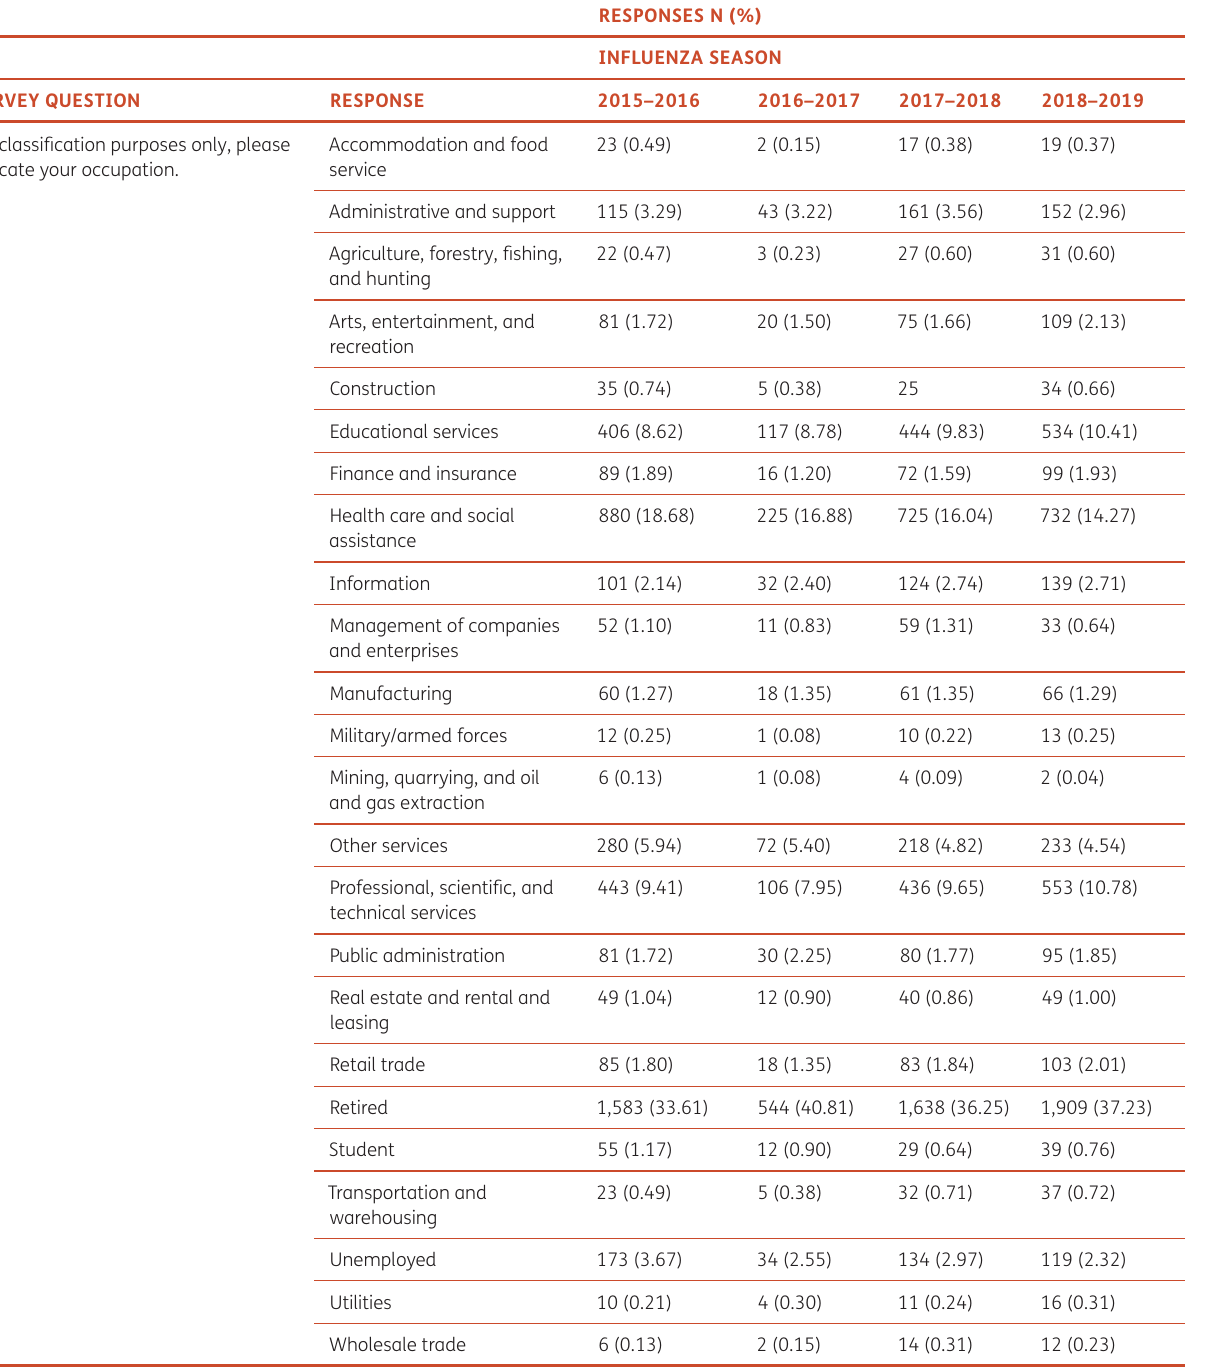
Table 3 2018–2019 user survey responses. Values are represented as n